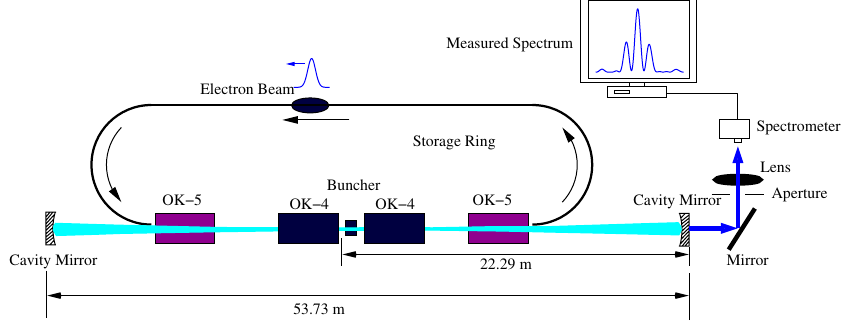
FIG. 11. (Color) A schematic of the experimental setup to measure the electron beam energy spread using a diagnostic optical klystron system on the Duke storage ring.